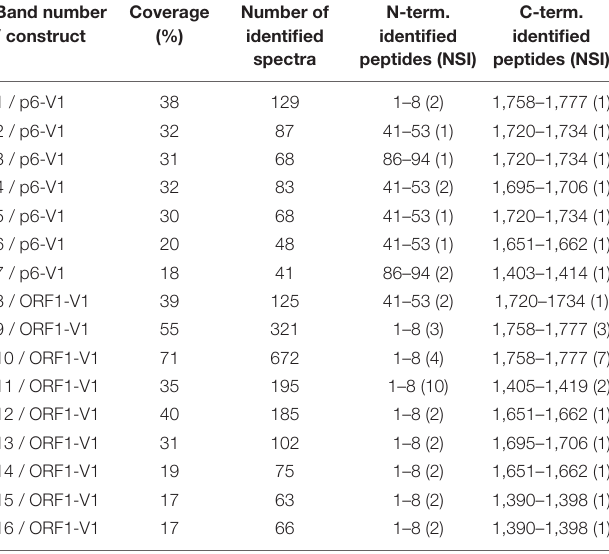
TABLE 3 | Mass spectrometry